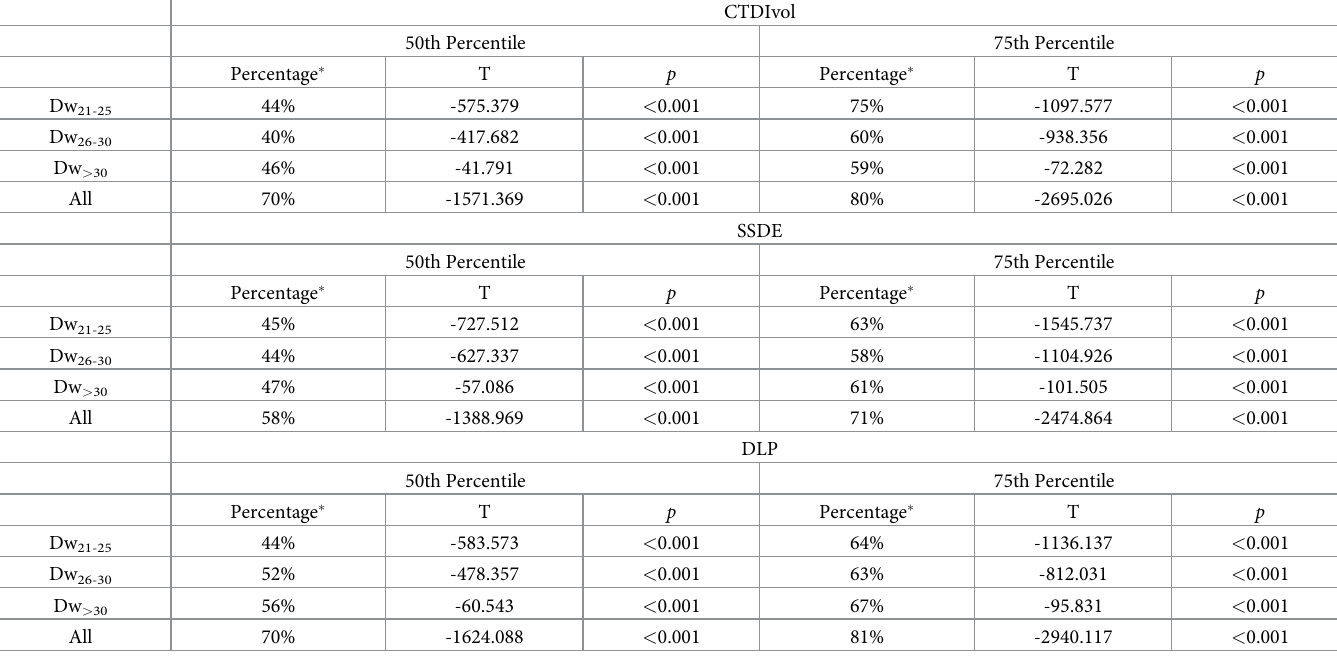
Table 6. Comparison of the CTDIvol, DLP, and SSDE with the 50 th and 75 th percentiles of ACR DRLs.